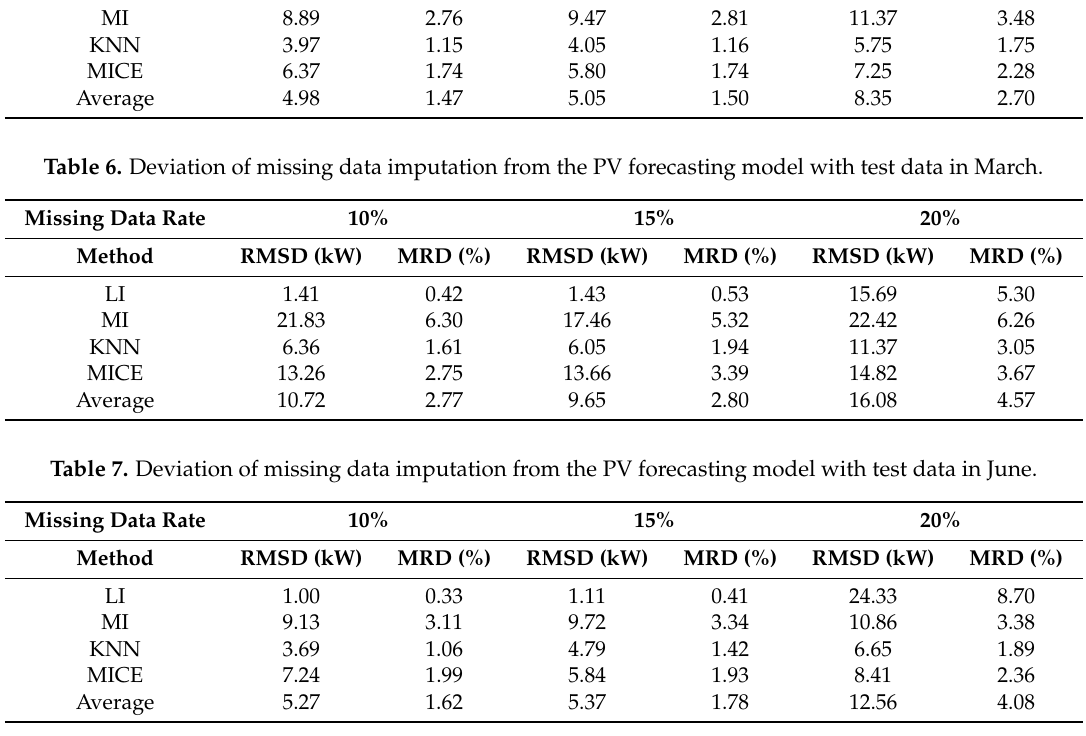
Table 5. Deviation of missing data imputation from the PV forecasting model with test data in January. Missing Data Rate Method